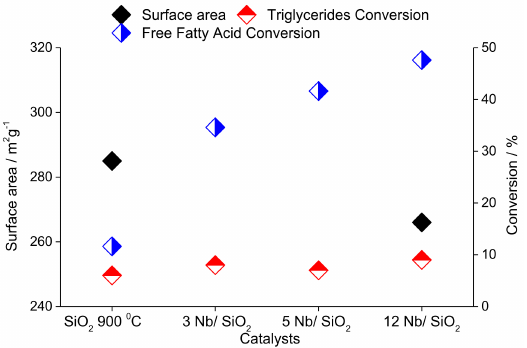
Figure 32. Conversion of triglycerides and free fatty acids of acid soybean oil over silica and Niobium/silica catalysts with methanol. Reaction conditions: soybean oil or acid soybean oil (2.00 g), catalyst (0.10 g), methanol (0.88 g), temperature (180 ◦ C), time (1 h) (adapted from